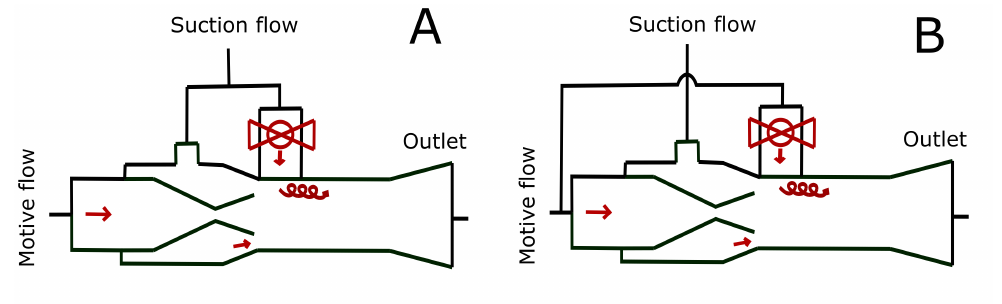
Figure 1. Illustration of the two swirl-bypass concepts ( A , B ). Concept ( A ) is a suction swirl bypass ejector. Concept ( B ) is a motive swirl bypass